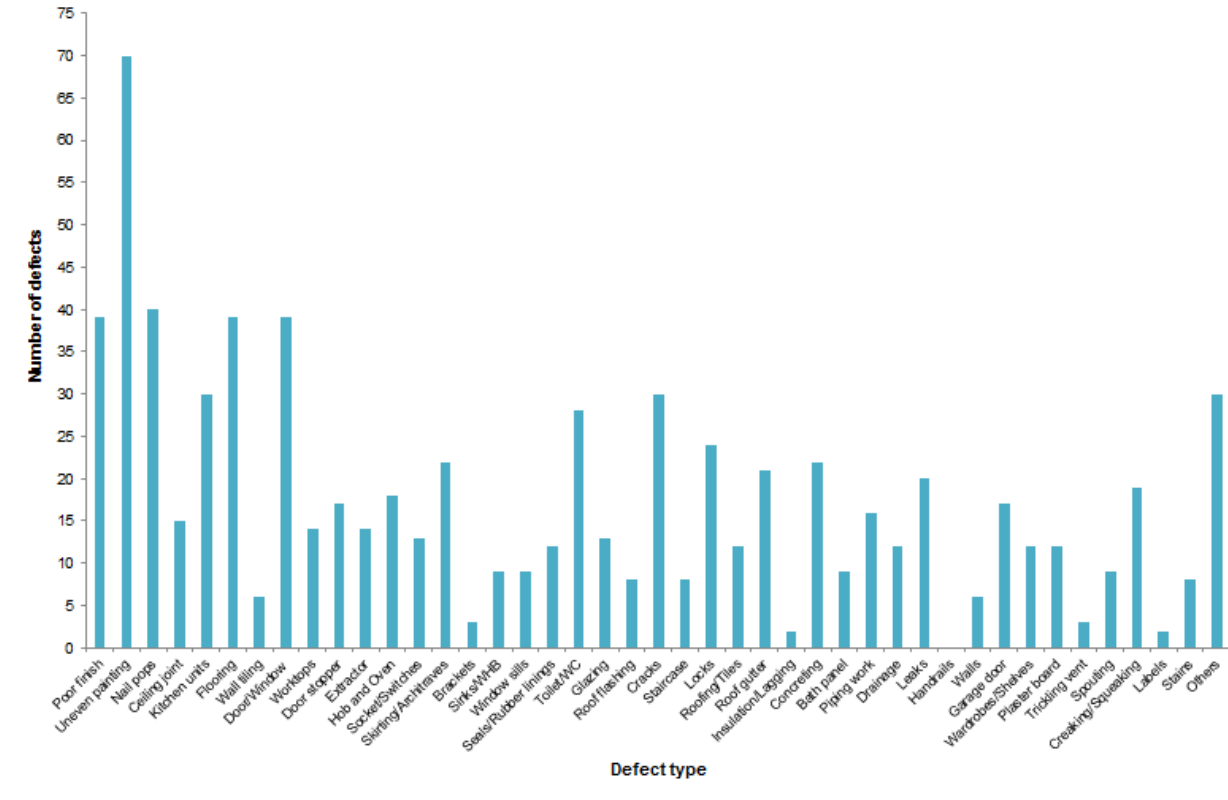
Figure 1. Common defects observed in new residential